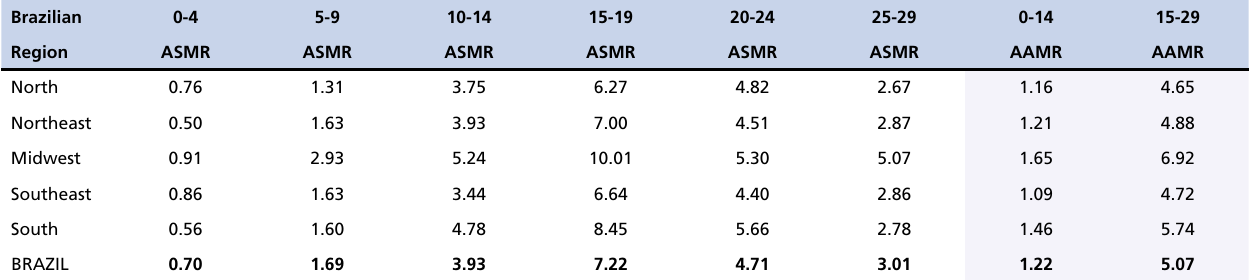
Table 3 – Age-specific and age-adjusted mortality rates of bone tumors in children, adolescents and young adults from Brazil, SIM 2009-2013.